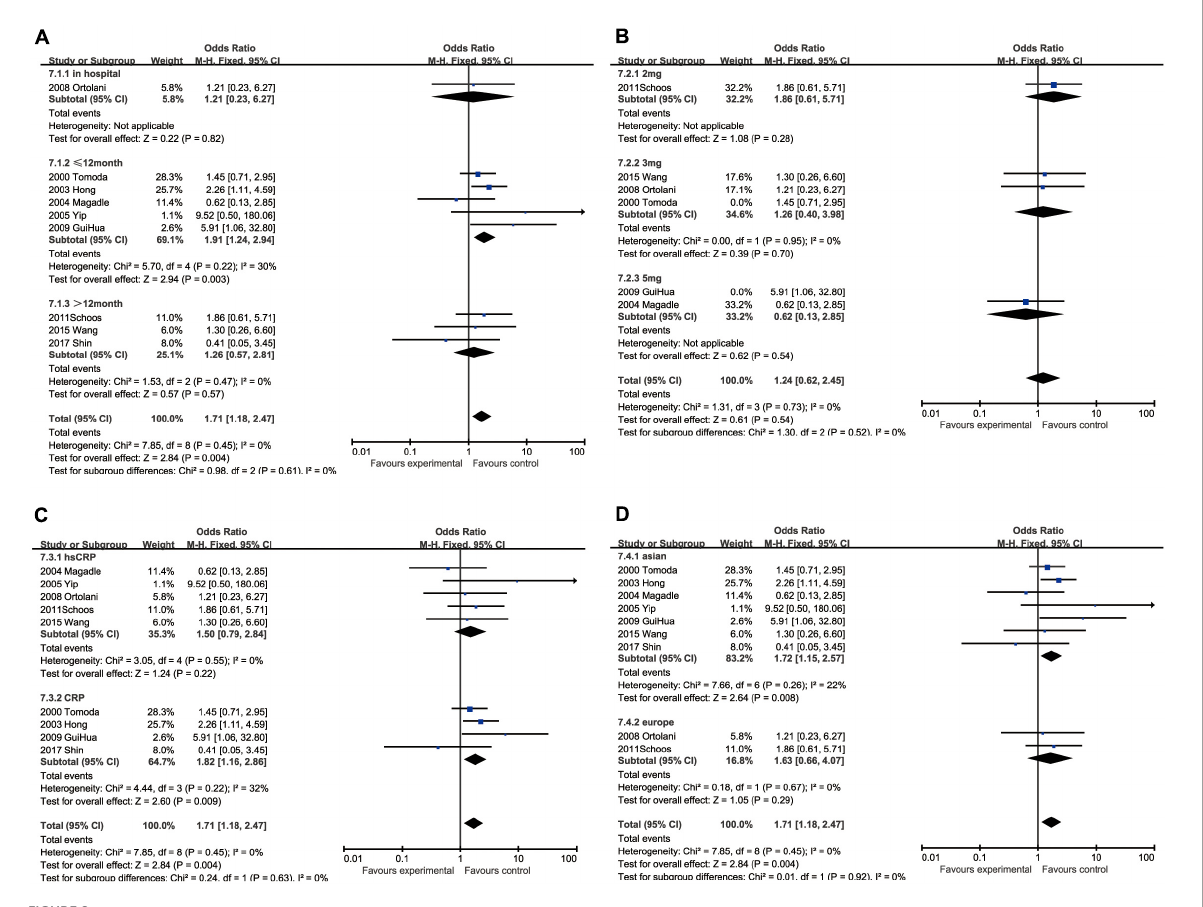
FIGURE8 Forrest plots of subgroup analysis assessing restenosis associated with increased CRP: (A) subgroups based on cut-off value of hsCRP; (B) subgroups based on CRP and hsCRP; (C) subgroups based on ethnicities; and (D) subgroups based on ethnicities.